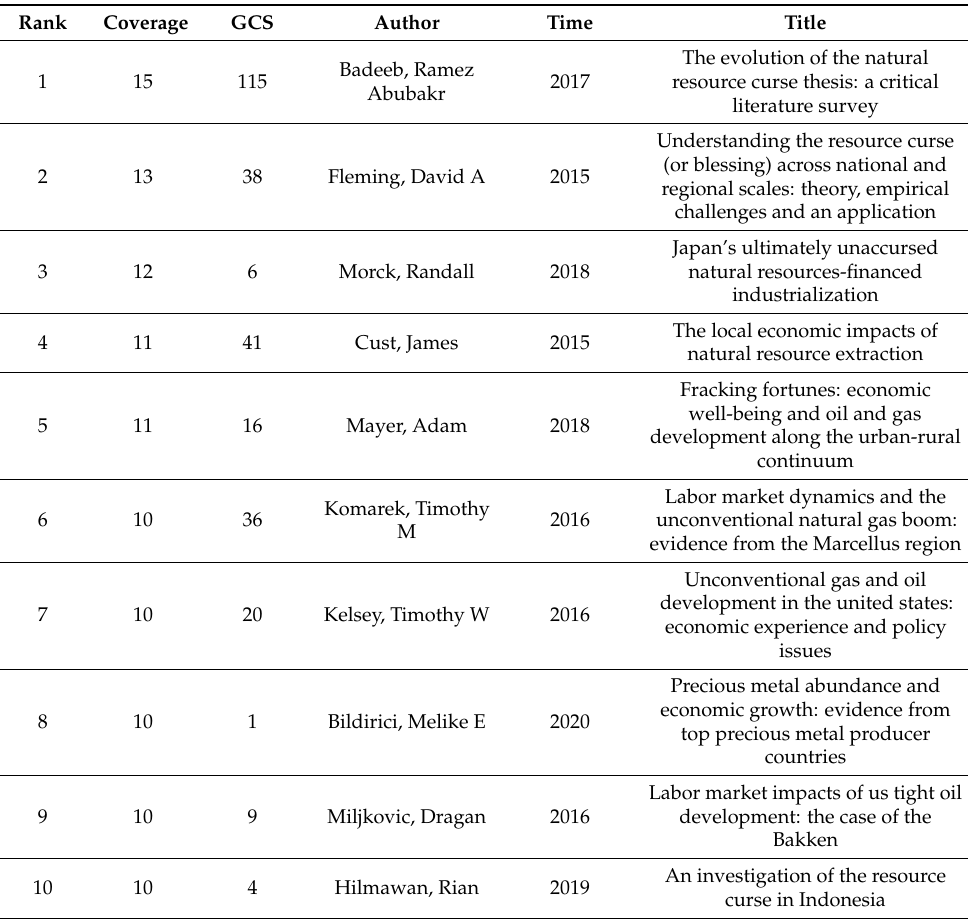
Table A6. Citing articles in Cluster